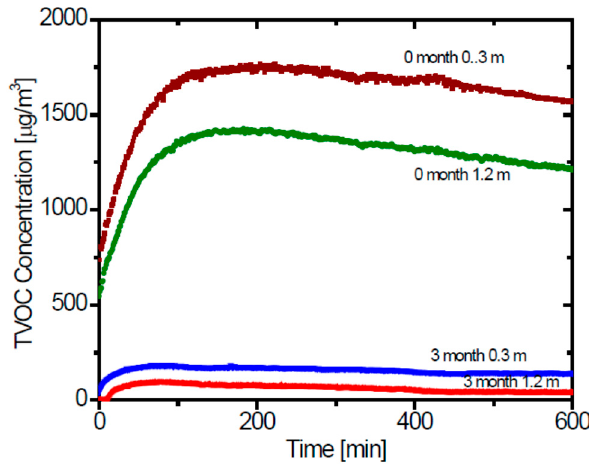
Figure 4. Time changes of the total volatile organic compound (TVOC) concentrations at Room B monitored using a PID after the windows had been closed, at just completion, and after three months.